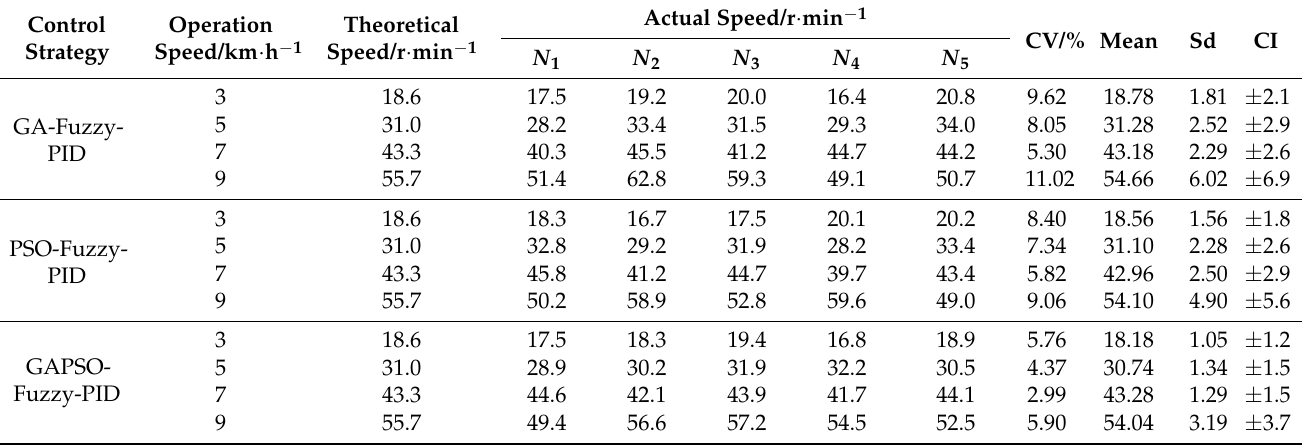
Table 4. Verification experiment table of seed metering device speed accuracy.